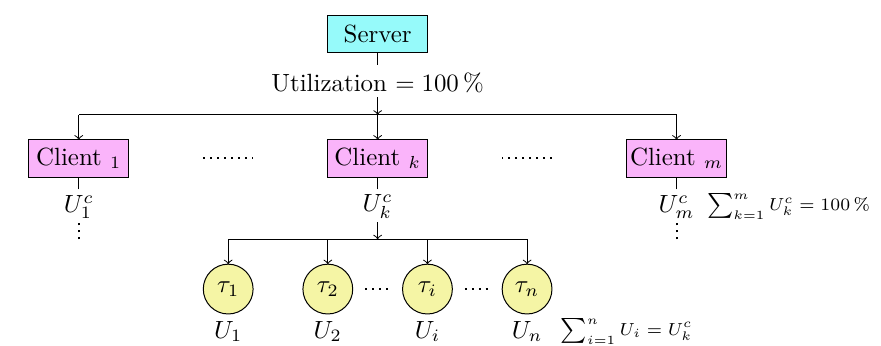
Figure 3 The distribution of the server’s